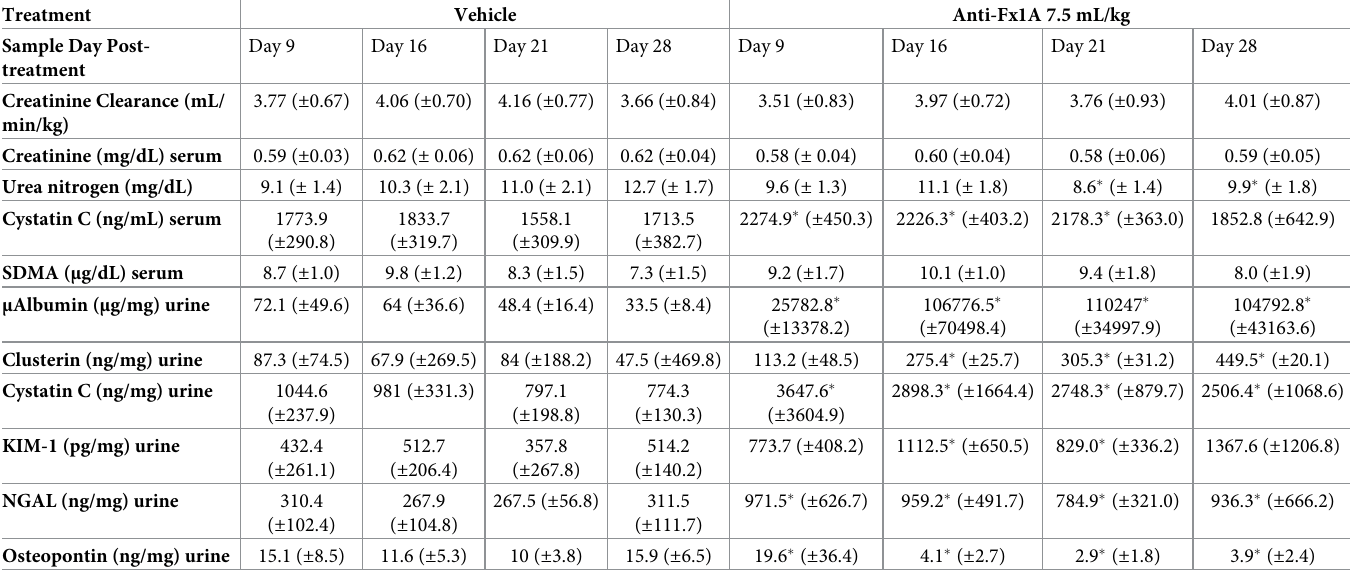
Table 2. Serum and urine kidney biomarker data for vehicle control and anti-Fx1A-treated rats. Treatment